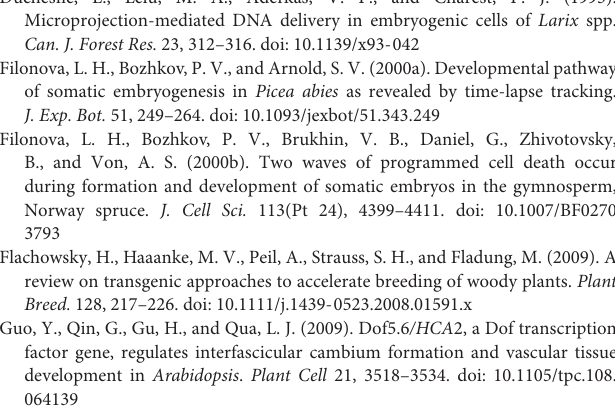
Supplementary Figure 1 | Schematic representation of binary expression vectors used in this study. Supplementary Figure 2 | Effect of antibiotics on the proliferation of embryogenic callus of L. olgensis . Supplementary Figure 3 | Comparison of the bacteriostatic effects of different concentrations of cefotaxime. Supplementary Figure 4 | Schematic representation of the timeline for A. tumefaciens -mediated transformation of L. olgensis embryogenic callus. Supplementary Figure 5 | The seedling transplanting of transgenic L. olgensis. Supplementary Table 1 | Efficiency and conditions of Agrobacterium- mediated genetic transformation of Larix. Supplementary Table 2 | Composition of BM (basic medium). Supplementary Table 3 | List of primers used for PCR. Supplementary Table 4 | Comparison of the number of mature somatic embryos and somatic embryo germination rate of transgenic and non-transgenic embryogenic callus of L.